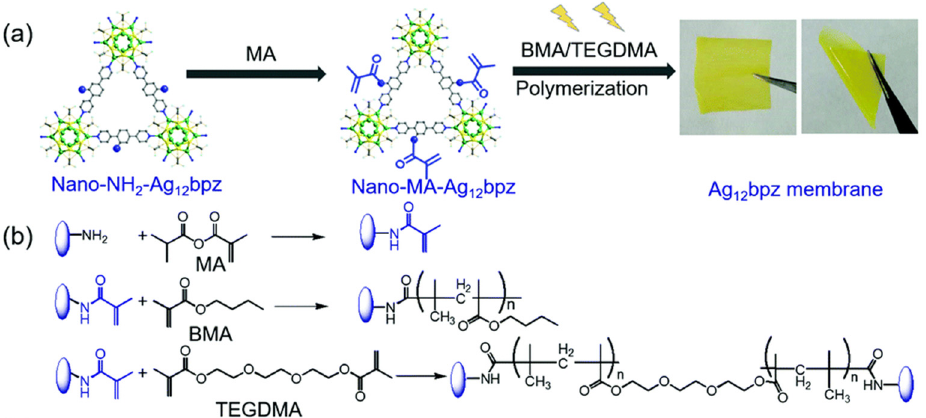
Figure 8. ( a ) The process of preparing Ag 12 bpz membrane from NH 2 -Ag 12 bpz. ( b ) Post-modification and cross-linking steps. Copyright 2019 Royal Society of